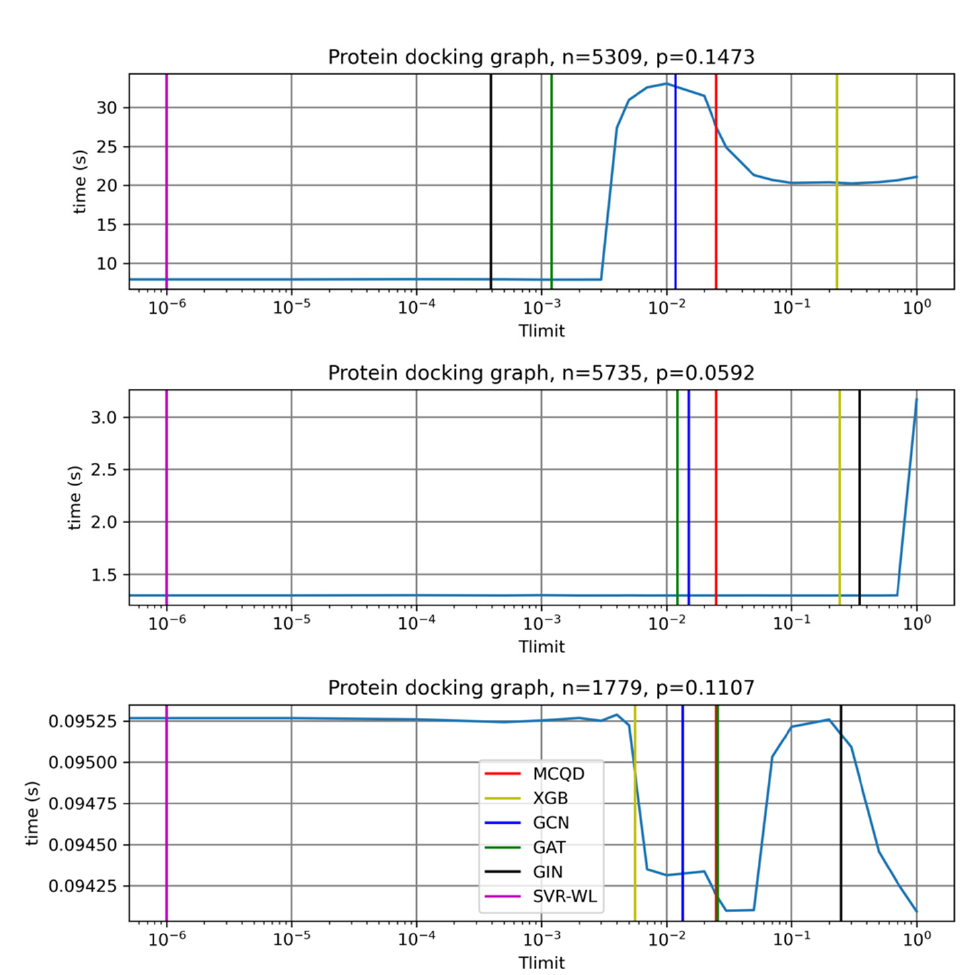
Figure 6. Time that MCQD algorithm and each variant of the MCQD-ML algorithm need to find the maximum clique on three different graphs from a test set of molecular docking graphs dependent of the Tlimit parameter.